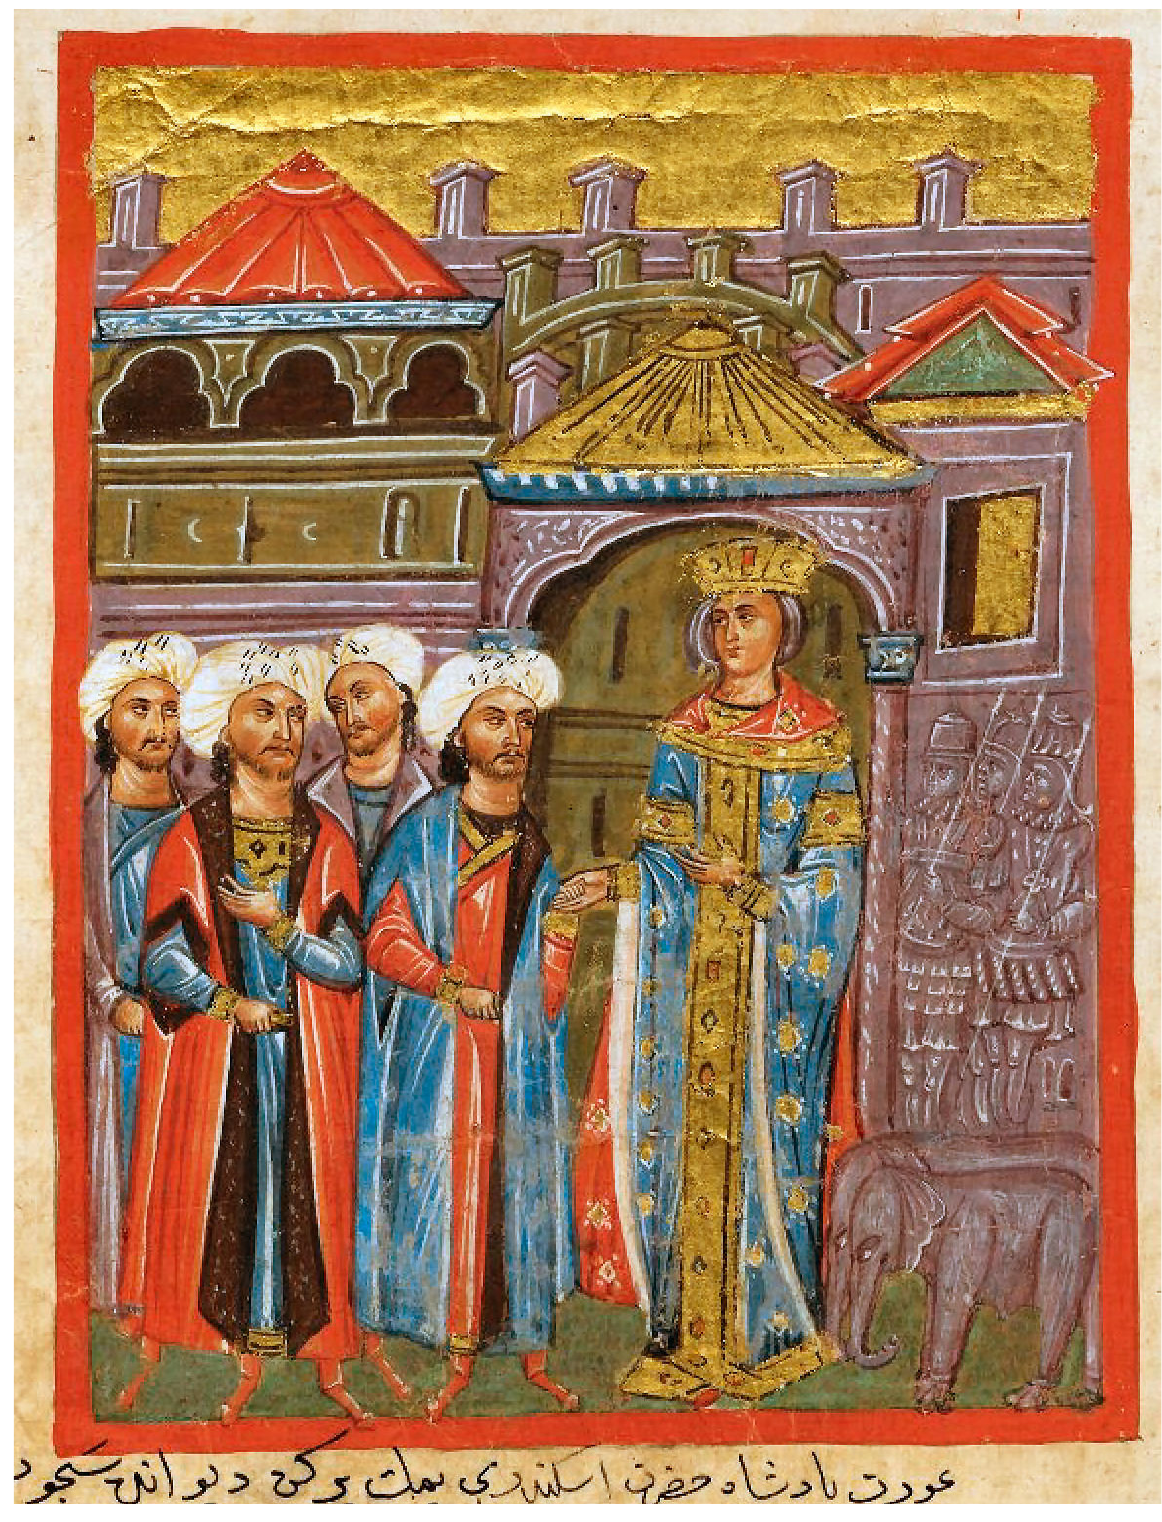
Figure 17. Venice. Istituto Ellenico di Studi Bizantini e Postbizantini cod. 5, fol. 160v (detail). Queen Kandake’s entrance. Photo: ©Istituto Ellenico di Studi Bizantini e Postbizantini, Venice, all rights